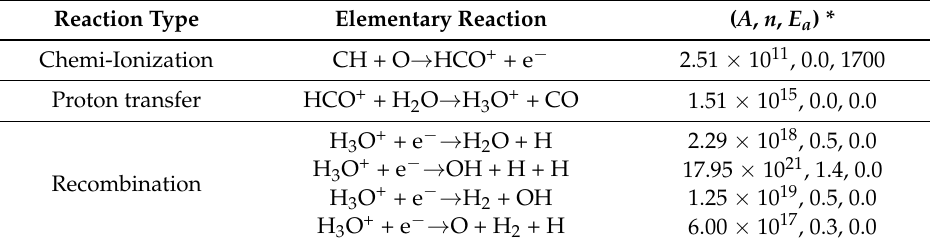
Table 1. Adopted ionic